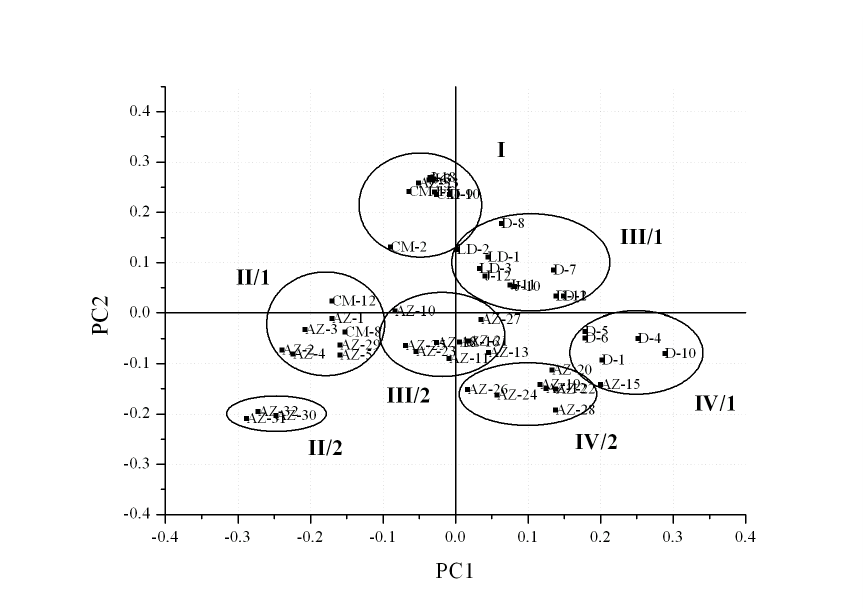
Fig. 3 Principal components scatter plot of the coal